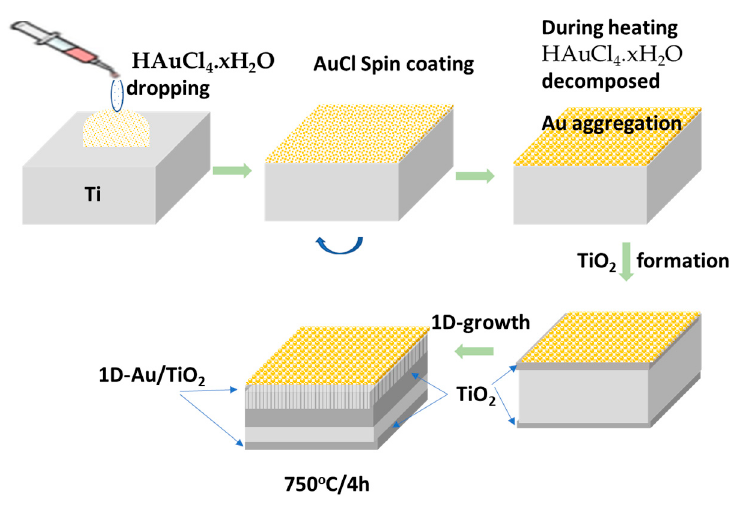
Figure 4. The scheme diagram described the growth mechanism of Au/TiO 2 nanostructures.